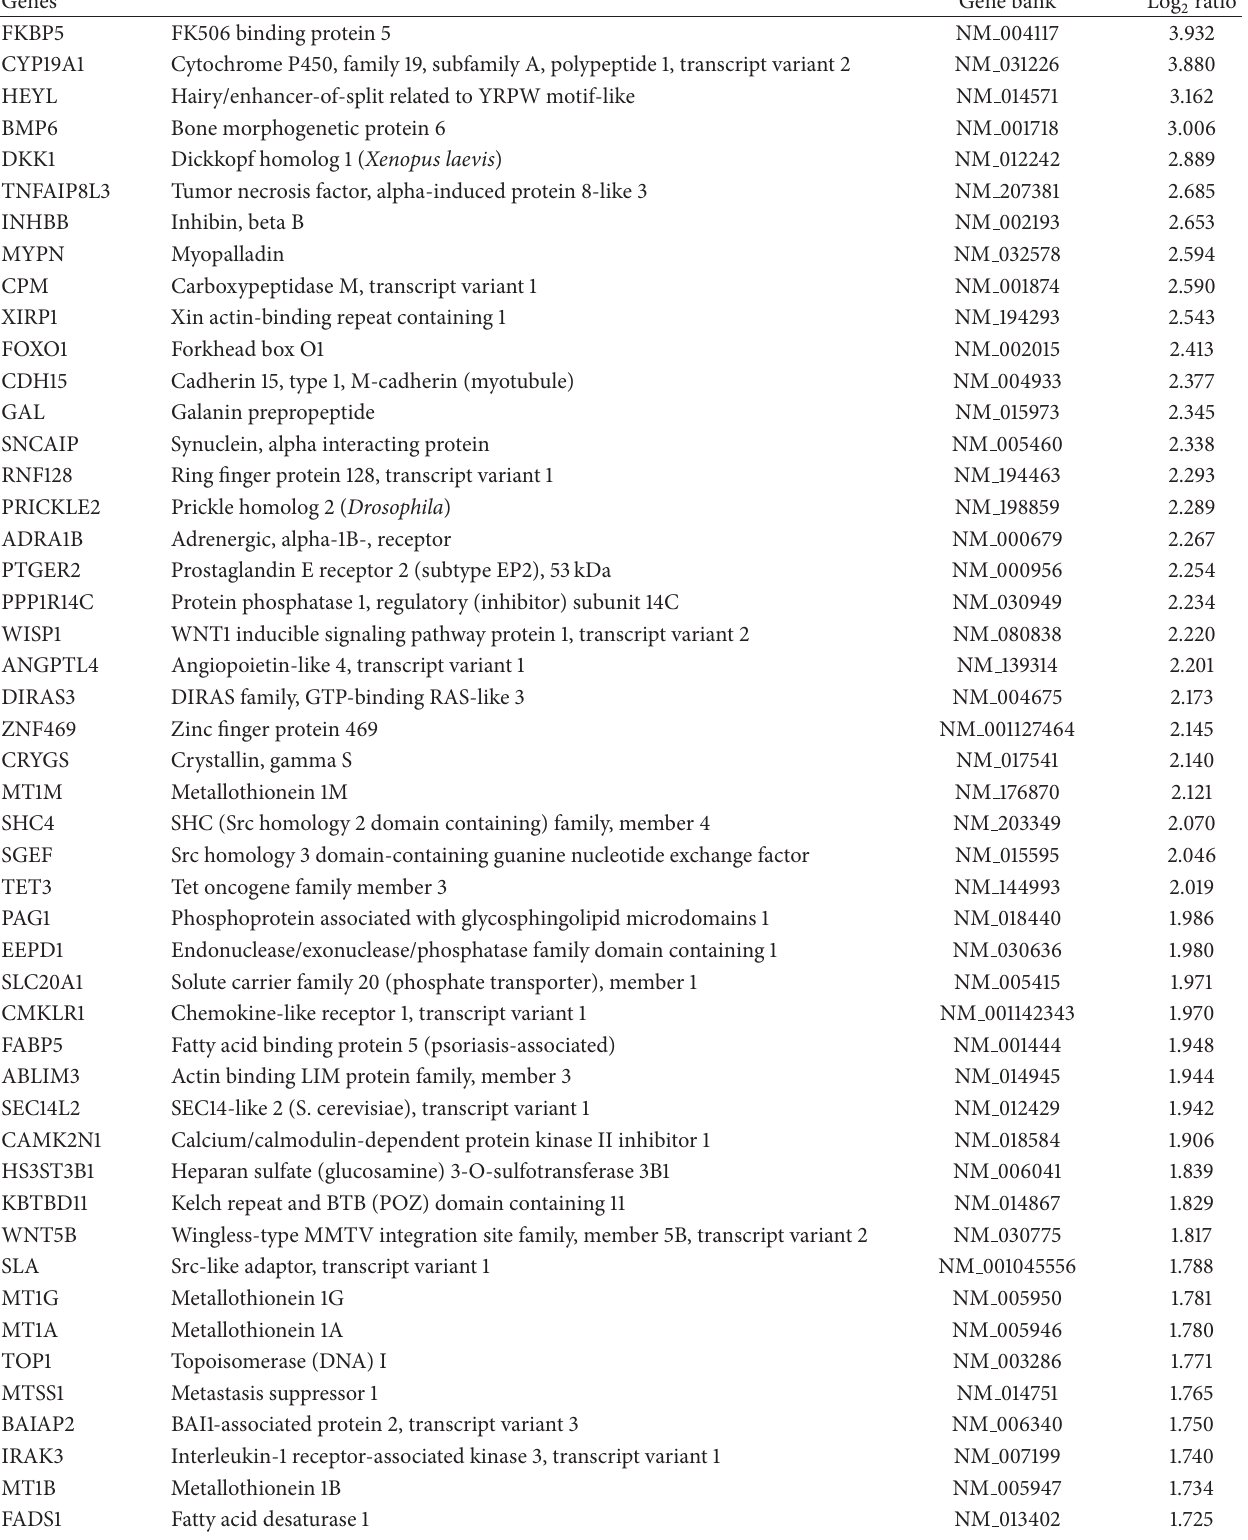
Table 2: Genes upregulated in hBMSCs by DEX treatment. Human genes upregulated by at least threefold in hBMSCs treated with DEX for 6 h at P5 compared with nontreated